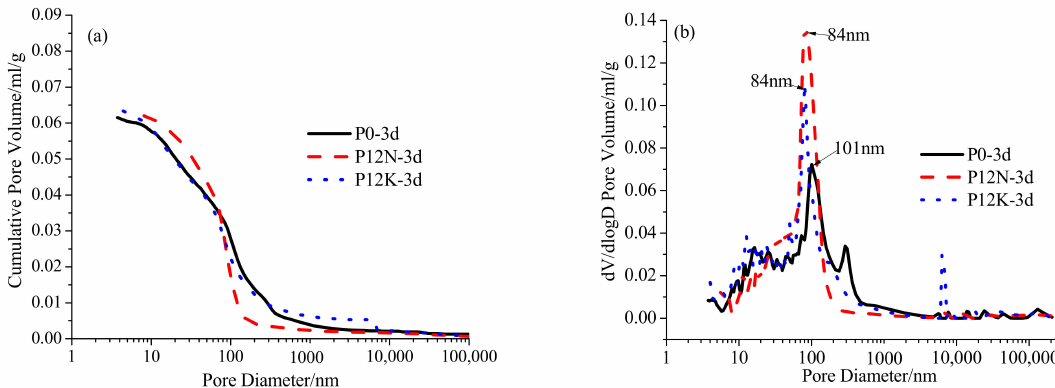
Figure 11. The curves of cumulative pore volume ( a ) and pore size distribution ( b ) of OPC mortars with different alkali sulfates contents at 3